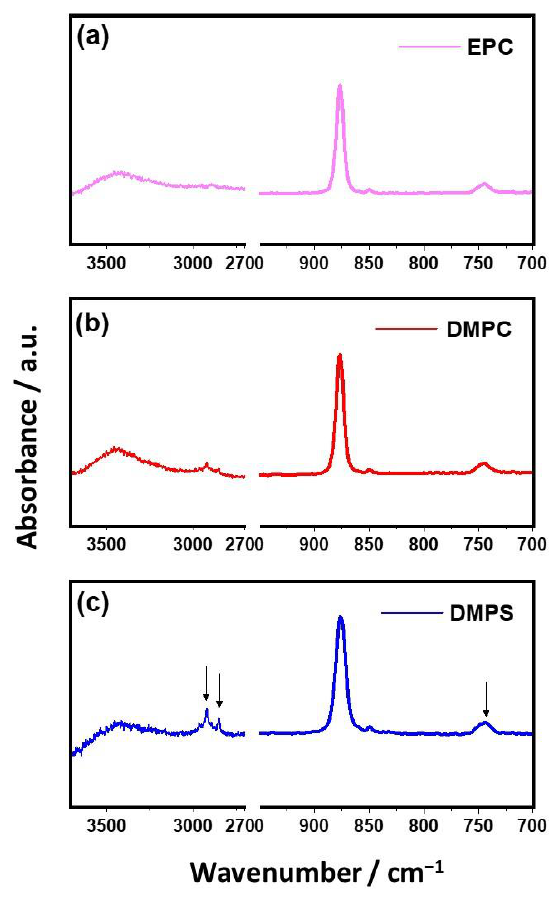
Figure 7. FTIR spectra of vaterite formed after 10 min of aging time in systems with the presence of different liposomes: ( a ) EPC, ( b ) DMPC, and ( c ) DMPS; c i (Ca) = c i (CO 3 ) = 20 mmol dm – 3 ; γ (lipid) = 25.0 ppm; pH i = 8.15; ϑ /°C = 25 ± 0.1. Arrows: characteristic absorbance band of vaterite, 746 cm −1 , and characteristic CH 2 stretching modes of liposome, 2851 cm −1 and 2912 cm −1 .